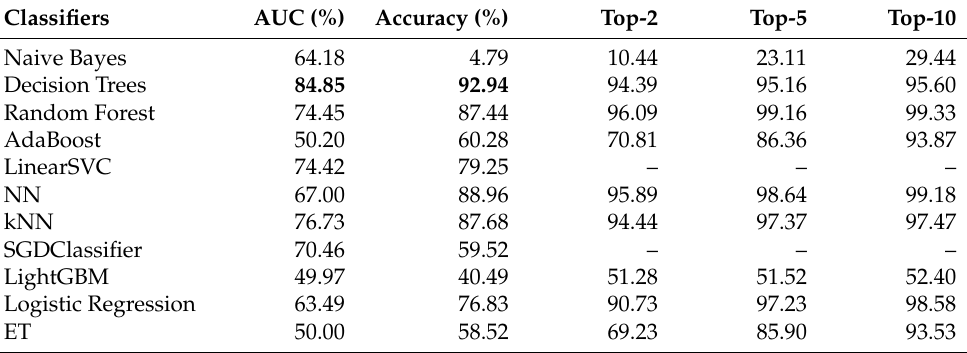
Table 2. Results based on the execution of each algorithm, but with 56 classes. With bold fold highlighted the optimal results of each column